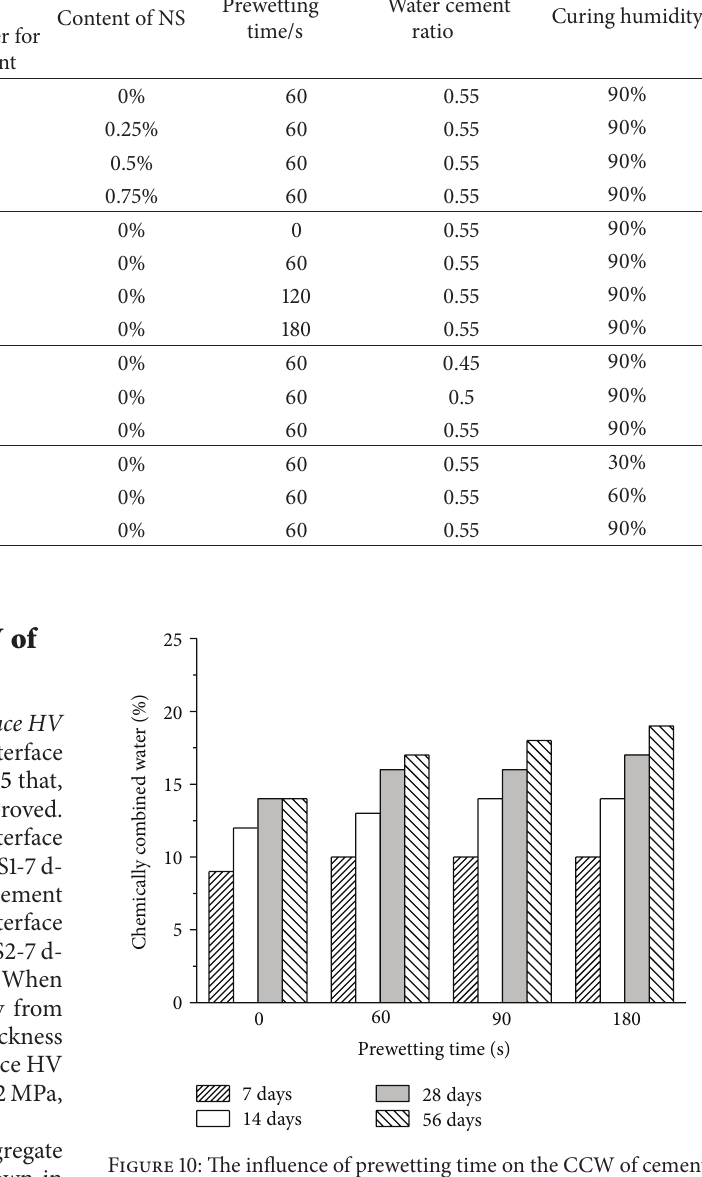
Figure 10: The influence of prewetting time on the CCW of cement paste around